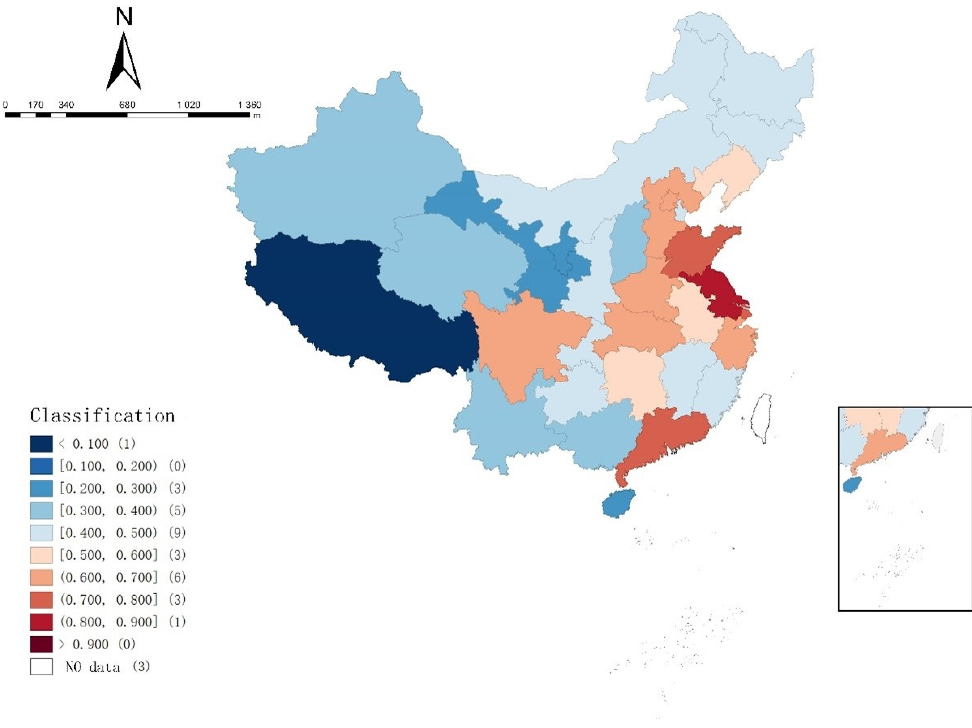
Figure 6. The spatial distribution of the coupling coordination degree of 31 regions (2020 to 2024).